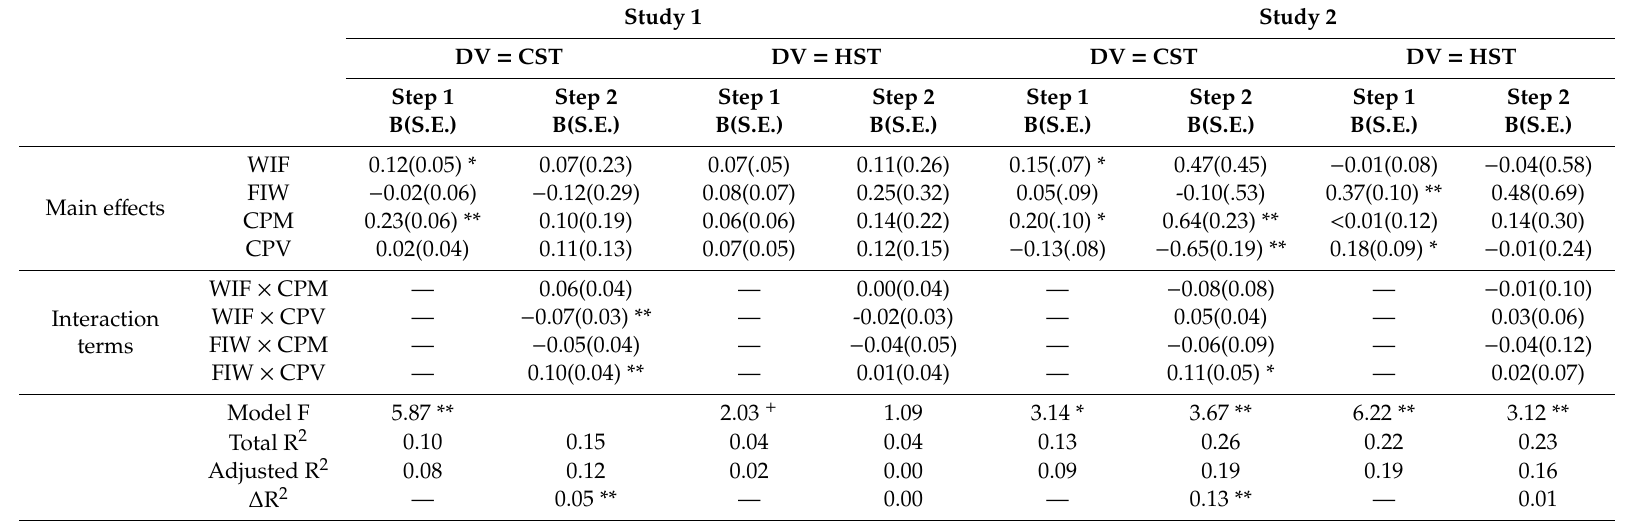
Table 5. Regression